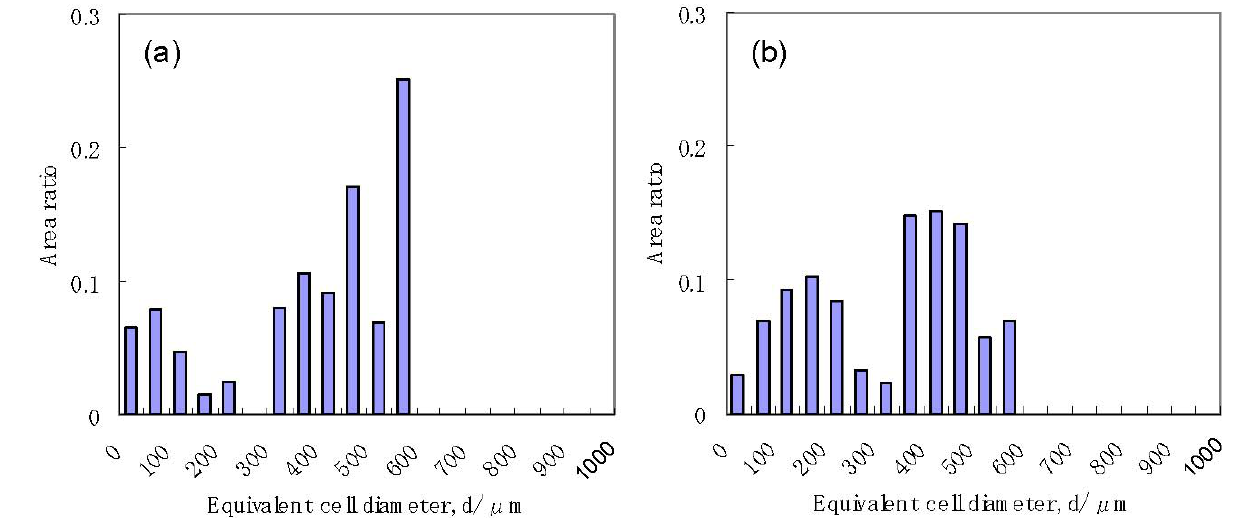
Figure 8. Cell size distributions of foam: ( a ) foam by dolomite, at 943 K, ρ : 0.88 g/cm 3 ; and ( b ) foam by multiple additions, at 903 K, ρ : 0.87 g/cm 3